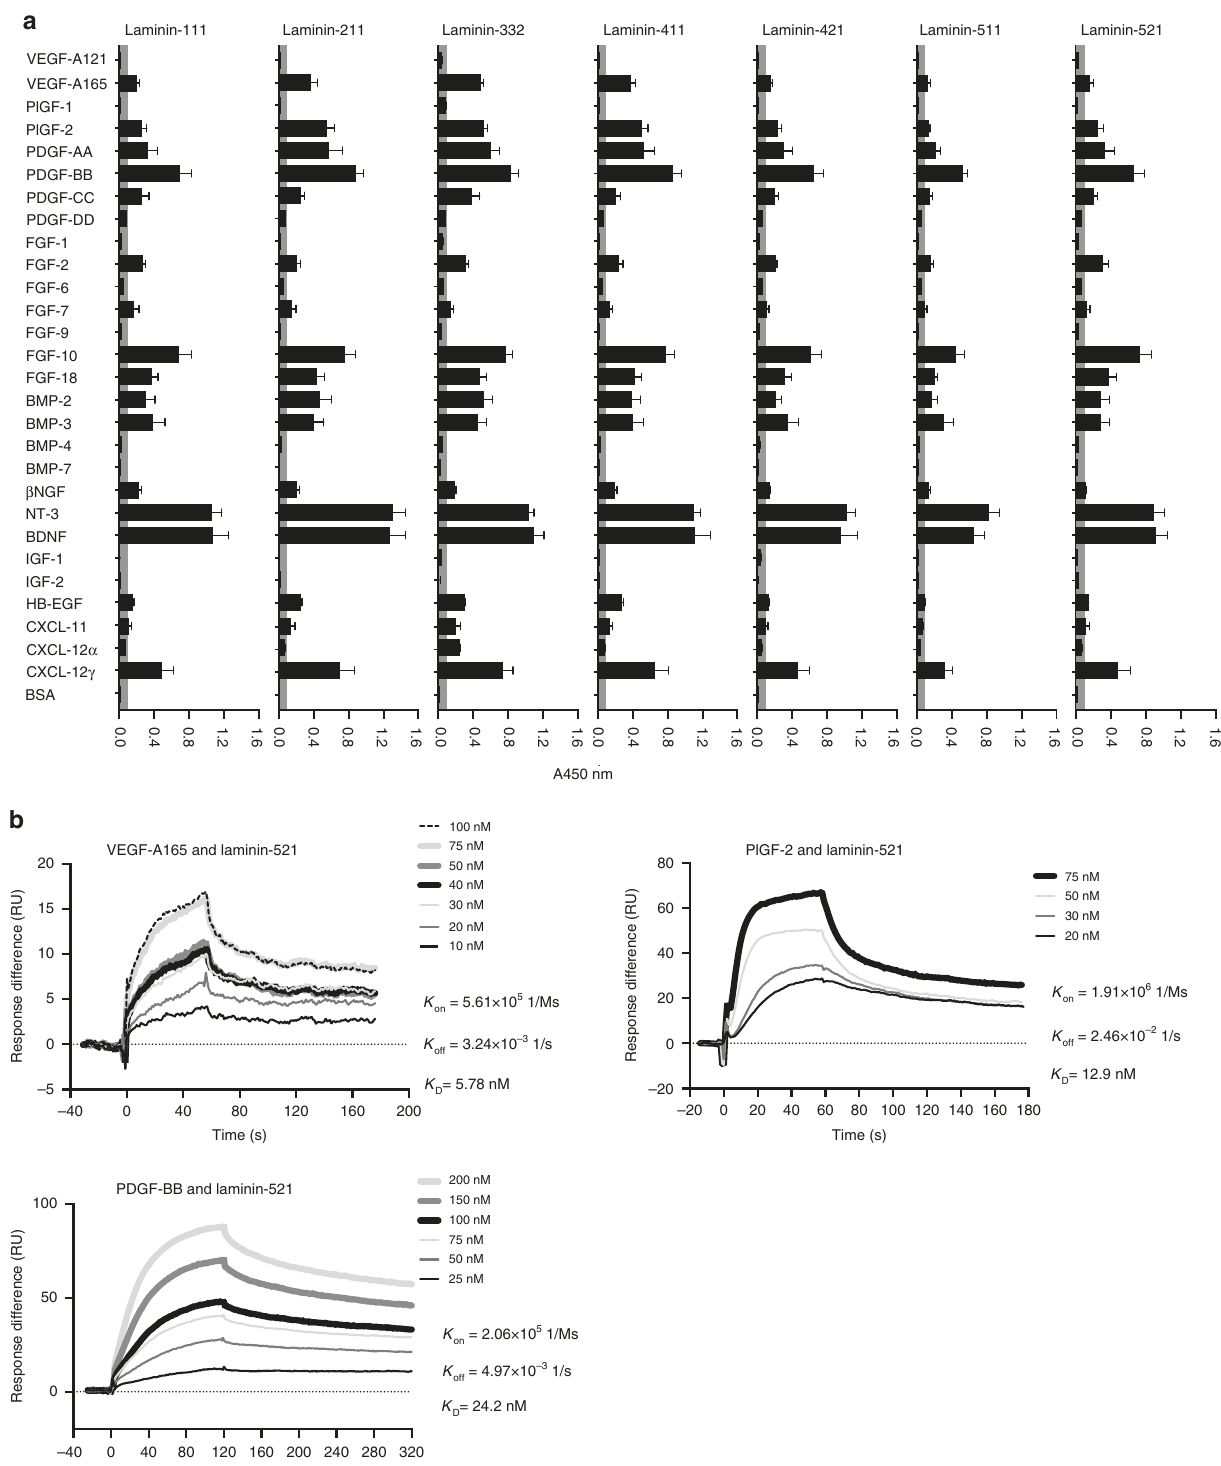
Fig. 1 Laminin binds promiscuously to GFs and chemokines. a Binding of multiple isoforms of full-length laminin ( – 111, – 211, – 332, – 411, – 421, – 511, and – 521) to GFs and CXCL chemokines were measured by ELISA. A450 nm represents absorbance at 450 nm. BSA-coated wells served as negative controls ( n = 4, mean ± SEM). Signals greater than 0.1 (gray box) are considered to be signi fi cant. b Af fi nities ( K D values are shown) of full-length laminin against VEGF- A165, PlGF-2, and PDGF-BB were measured by SPR. A SPR chip was functionalized with laminin-521 (~2000 resonance units (RU)), and each GF was fl own over the chip at indicated concentrations. Curves represent the speci fi c responses (in RU) to laminin obtained. Experimental curves were fi tted with Langmuir binding kinetics. Binding kinetics values [dissociation constants ( K D ) and rate constants ( K on and K off )] determined from the fi tted curves are shown. Two experimental